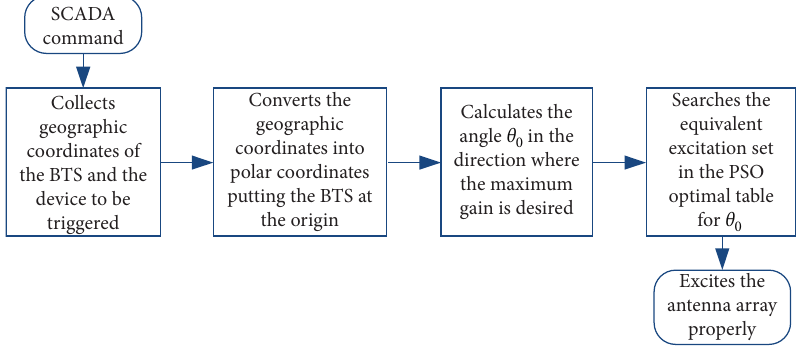
Figure 9: Flowchart of the process of phase shift